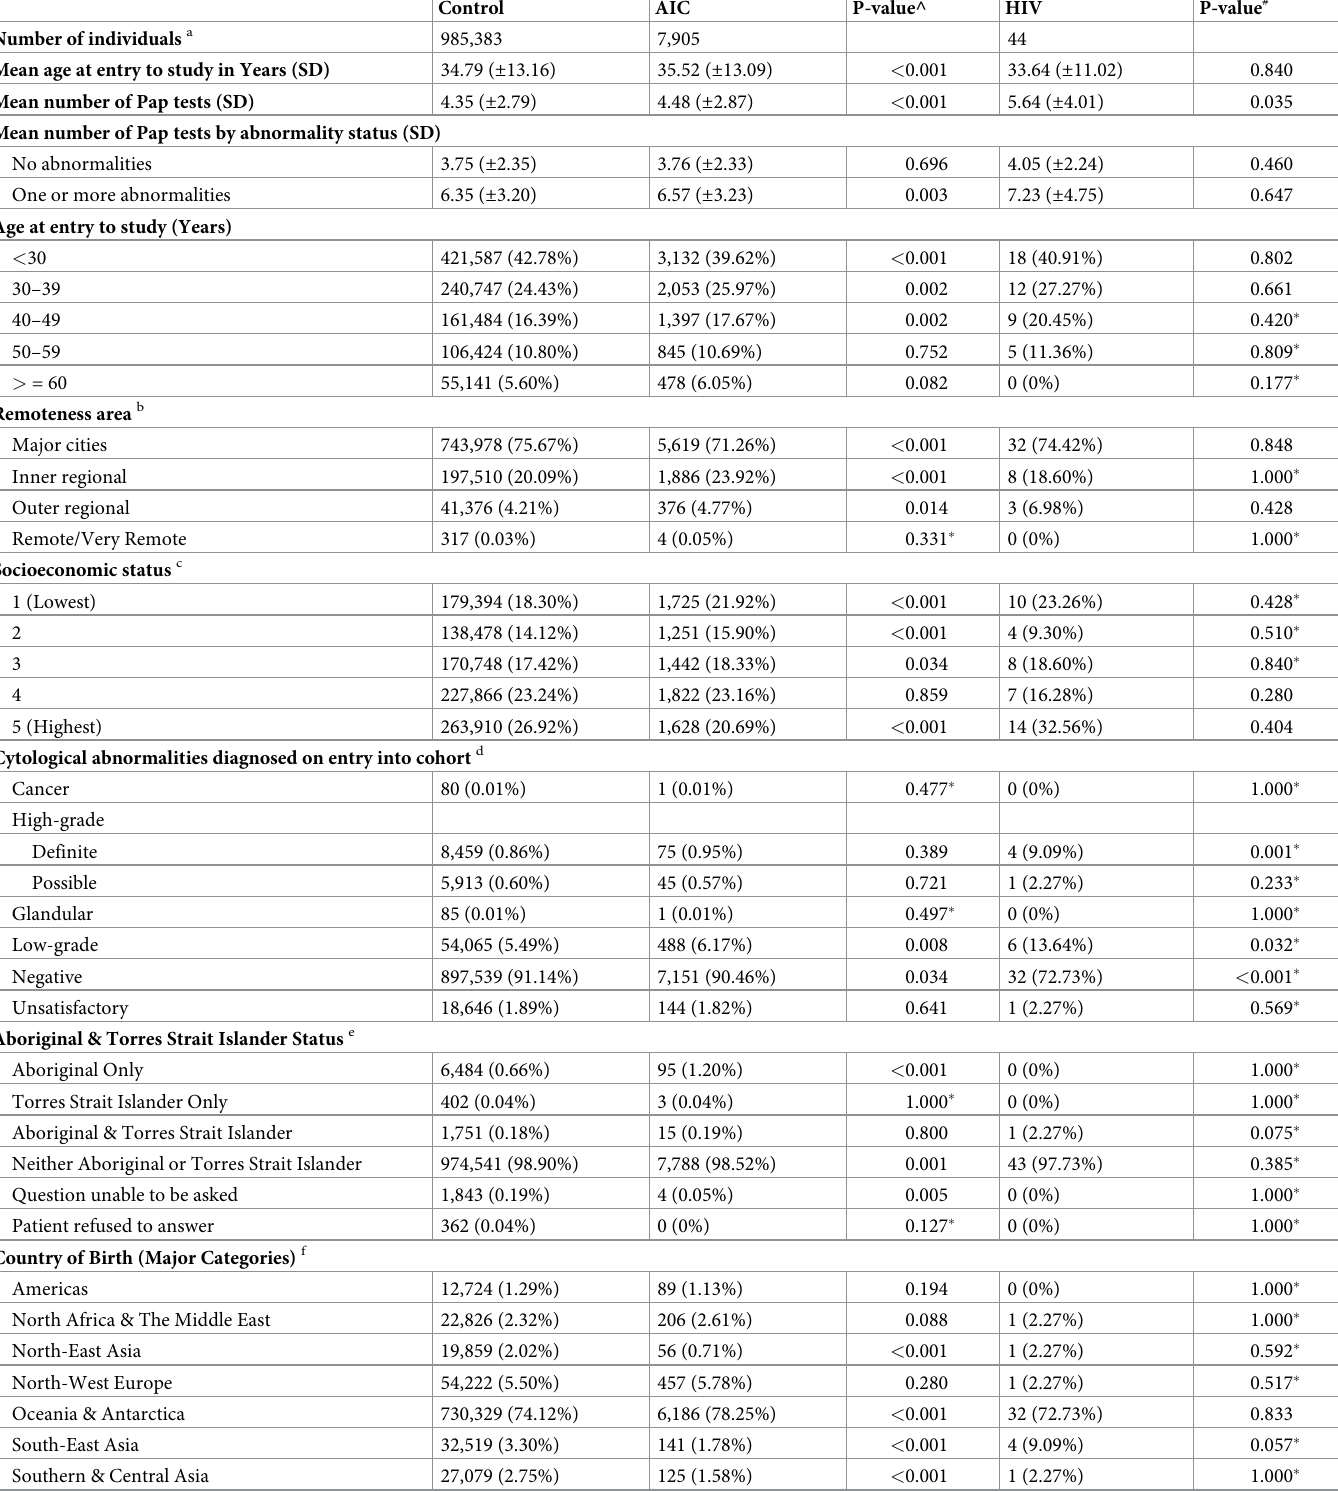
Table 1. Descriptive characteristics of the control, auto-immune condition (AIC) and HIV